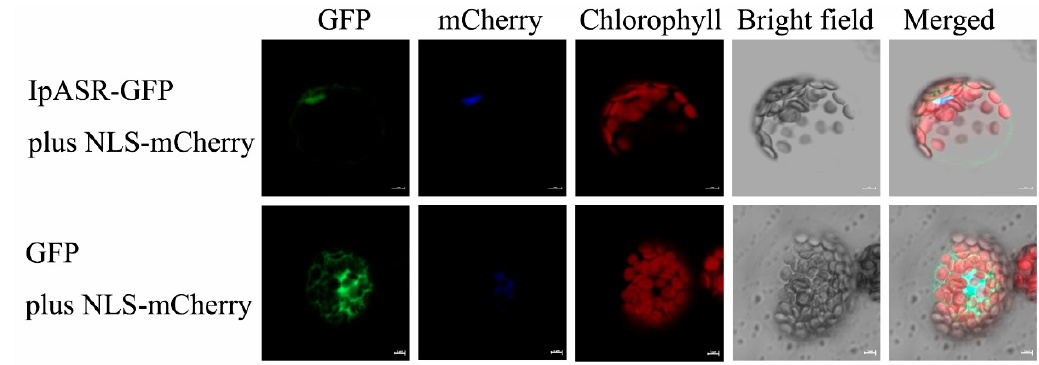
Figure 5. Subcellular localization of IpASR. Arabidopsis protoplasts expressing the IpASR-GFP fusion protein (upper) and GFP (lower) observed under a laser scanning confocal microscope. The blue color indicates the nucleus using mCherry as the nuclear marker. The red color indicates the autofluorescence emitted by chloroplasts. The bar represents 5 μ m.